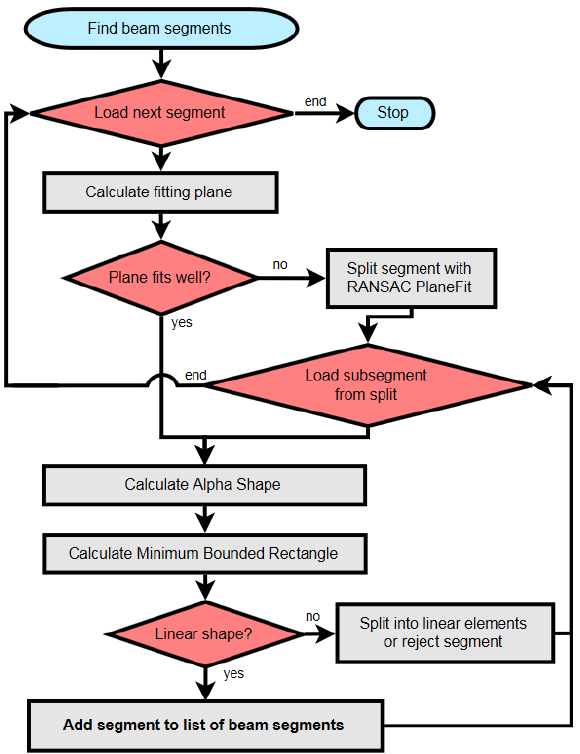
Figure 3: Flow chart of beam segment classification